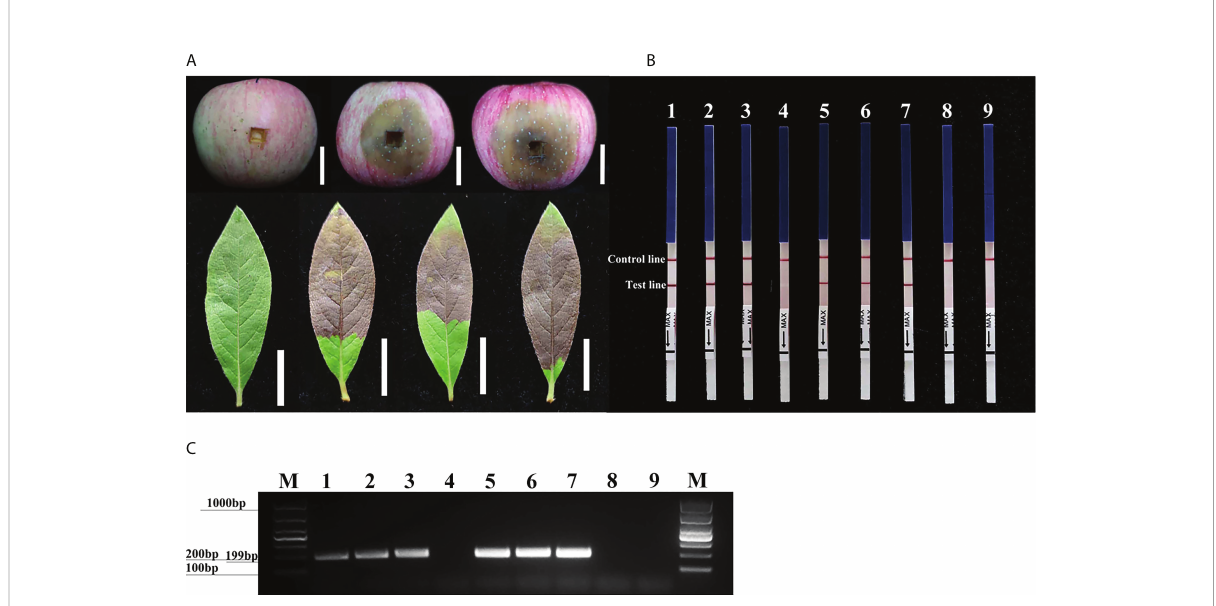
FIGURE 5 Detection of Phytophthora cinnamomi in arti fi cially inoculated fruit from Malus pumila “ FuJi ” Mill. and the leaves of Rhododendron pulchrum Sweet using Pcinn13739 RPA-LFD and conventional PCR assays. (A) 1 – 2, arti fi cially inoculated M. pumila “ FuJi. ” 3, a healthy apple as a negative control. 4 – 6, arti fi cially inoculated R. pulchrum leaves. 7, a healthy leave as a negative control. The white scale bar represents 2cm. (B) The detection of arti fi cially inoculated samples by the RPA-LFD assay. 1 – 2, arti fi cially inoculated M. pumila “ FuJi. ” 3, a non-inoculated apple as a negative control. 4 – 6, arti fi cially inoculated R. pulchrum leaves. 7, non-inoculated leave as a negative control. NTC, ddH 2 O as template. Genomic DNA (100 ng) of P. cinnamomi was used as a template in positive control (PTC). All dipsticks yielded visible control lines, indicating valid tests. (C) Detection of gDNA extracted from arti fi cially inoculated samples by conventional PCR assay. 1 – 2, arti fi cially inoculated M. pumila “ FuJi. ” 3, non-inoculated apple as a negative control. 4 – 6, arti fi cially inoculated R. pulchrum leaves. 7, non-inoculated leave as a negative control. Negative control (NTC), ddH 2 O as template. M, Marker DL1000 (Takara Shuzo, Shiga, Japan). Genomic DNA (100 ng) of P. cinnamomi was used as a template in positive control (PTC). Each set of experiments was repeated in triplicate with the same